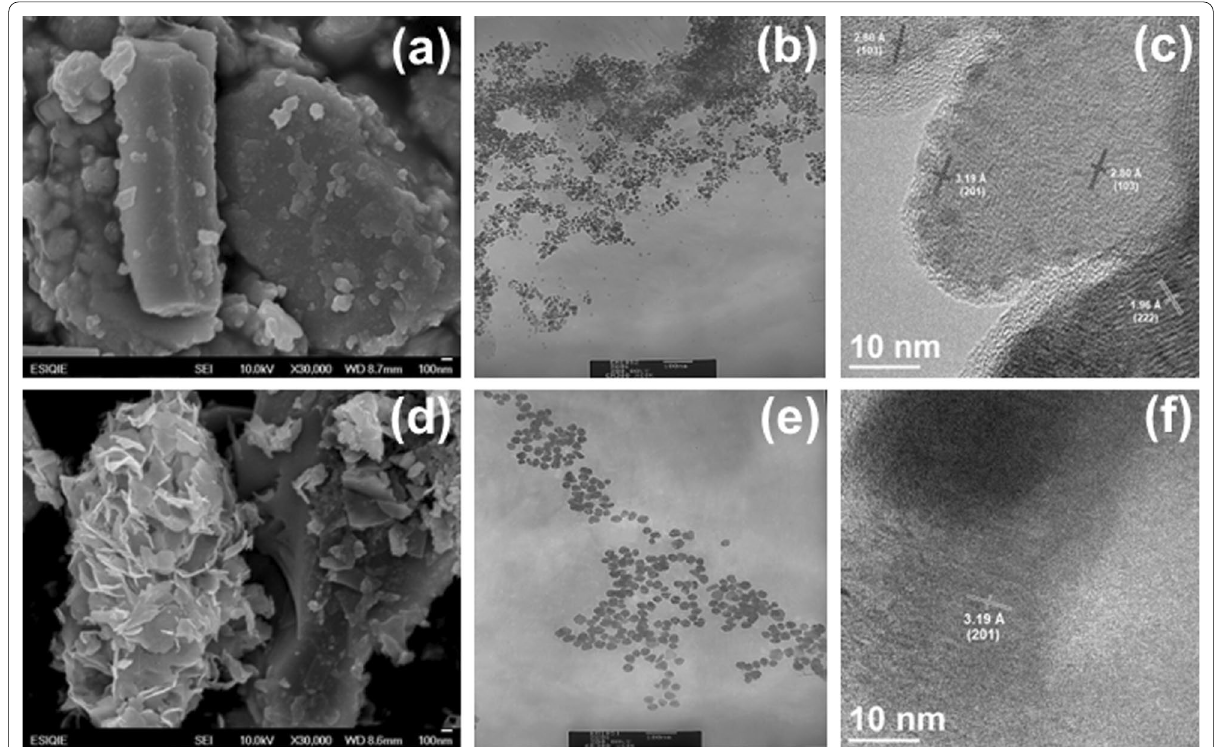
Fig. 3 FESEM images, TEM images, HR‑TEM, and FFT analysis as‑synthesized